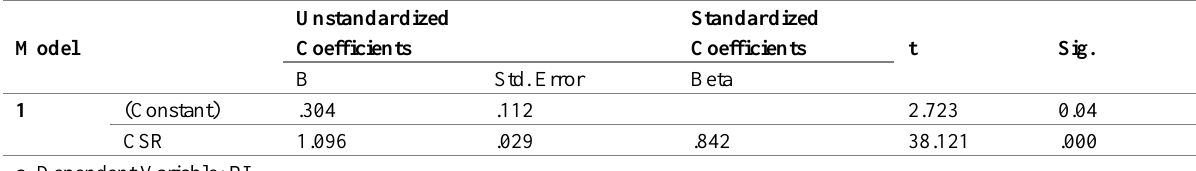
Table 12: Results of Linear Regression between Corporate social responsibility and Purchase